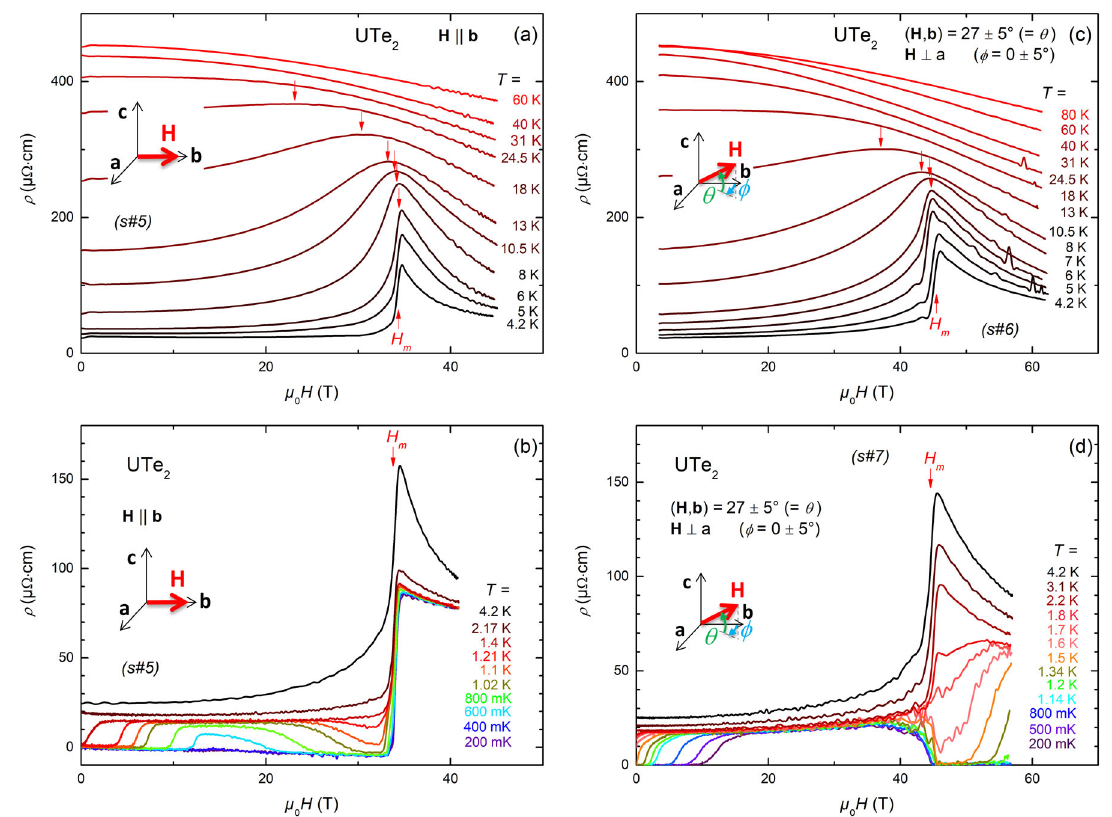
Fig. 2 Electrical resistivity of UTe 2 versus magnetic fi eld. a High-temperature and b low-temperature resistivity of UTe 2 in a magnetic fi eld H || b . c High- temperature and d low-temperature resistivity of UTe 2 in a magnetic fi eld H tilted by 27 ± 5° from b in the ( b , c )